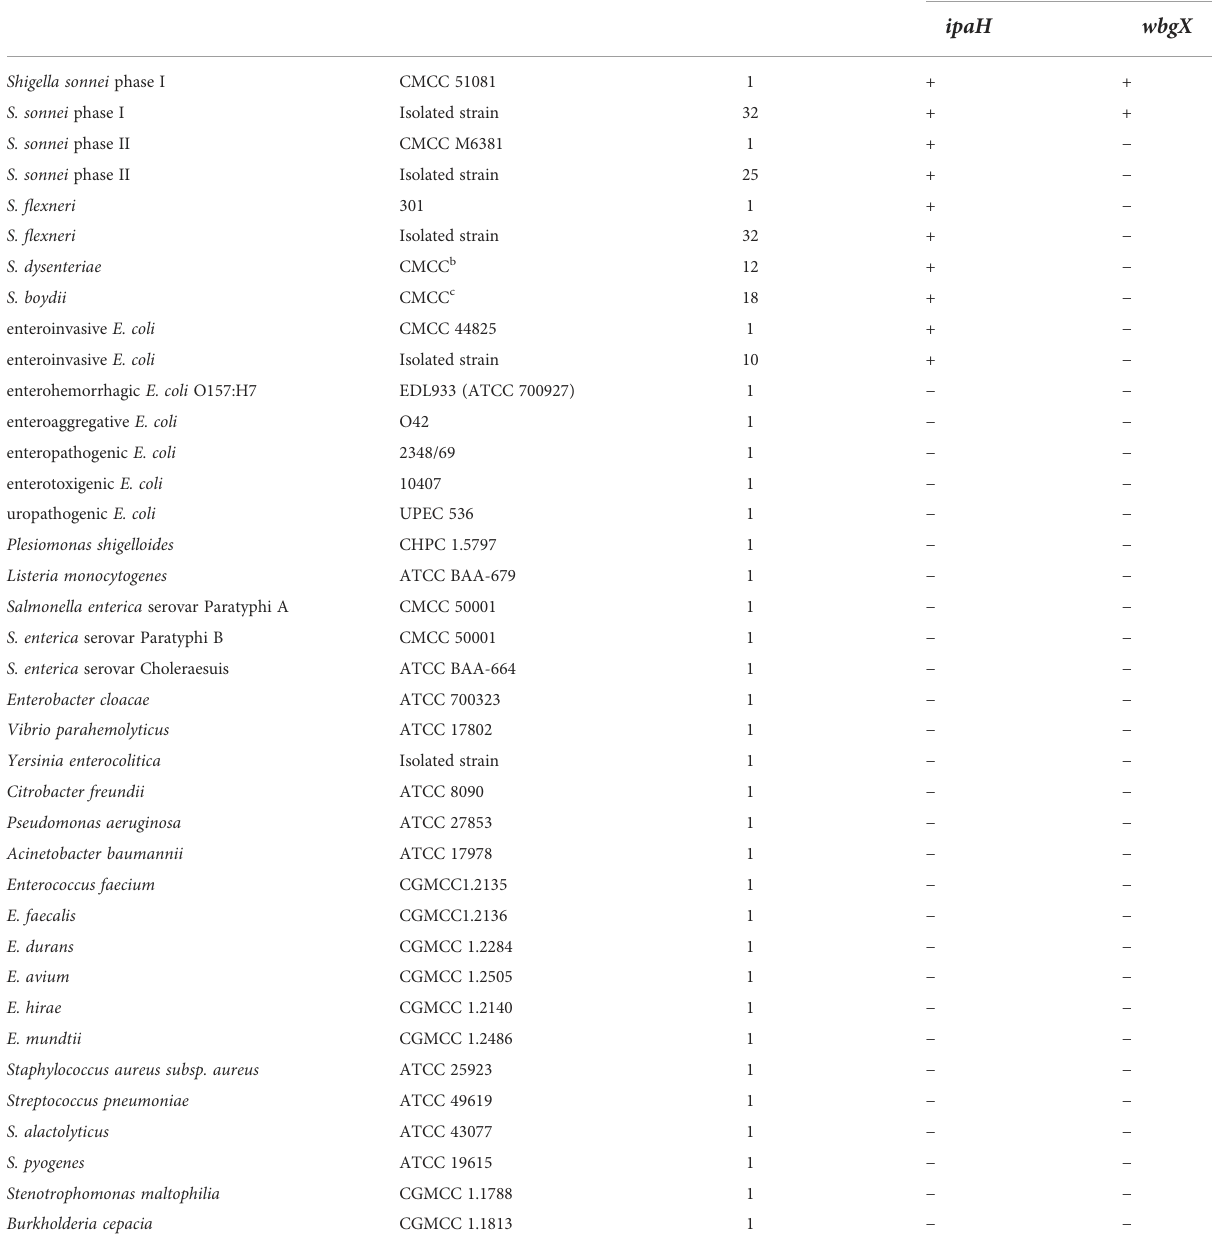
TABLE 1 Strains used in this study and the results of MCDA assays.